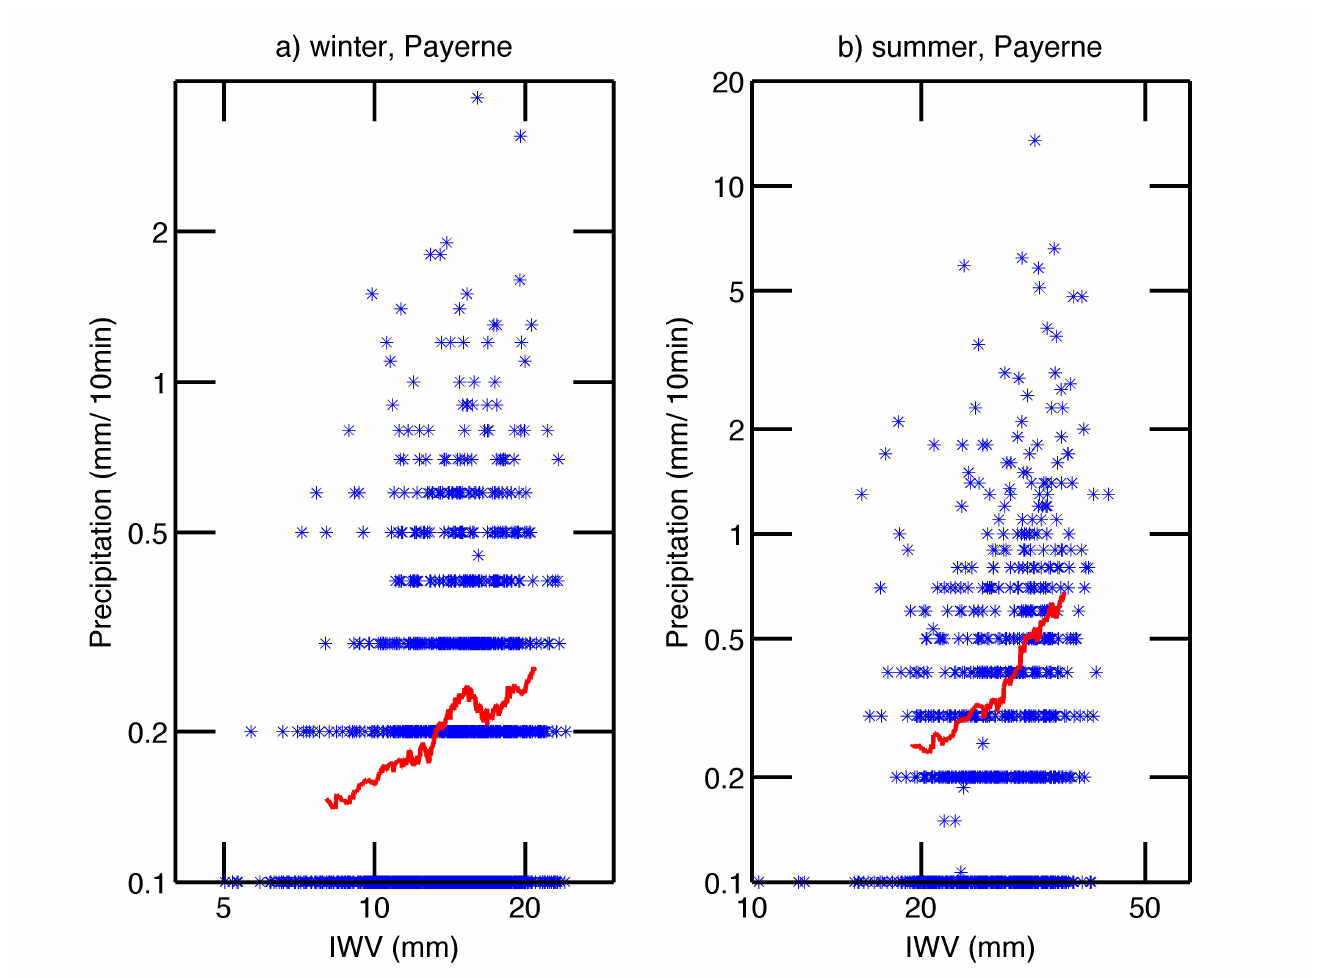
Figure 3. Relationship between the precipitation rate (rain gauge) and IWV (GNSS) in ( a ) winter and ( b ) summer at Payerne from June 2001 to March 2018 (double logarithmic plot). Data pairs are shown for a precipitation rate ≥ 0.1 mm/10 min. The red curve is the moving average over 250 data